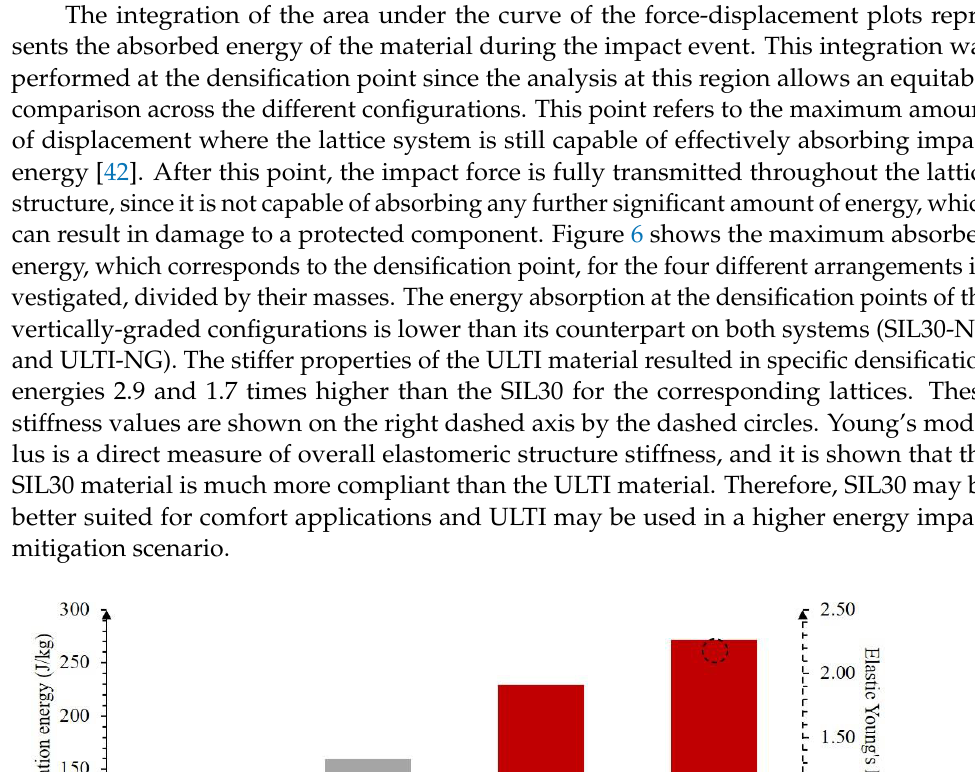
Figure 5. Force versus displacement of SIL30 and ULTI at different impact energies; ( a ) SIL30-NG, ( b ) SIL30-VG, ( c ) ULTI-NG, ( d ) ULTI-VG. Densification points are labeled; however, ULTI-NG does not show densification in these graphs due to its stiffness.